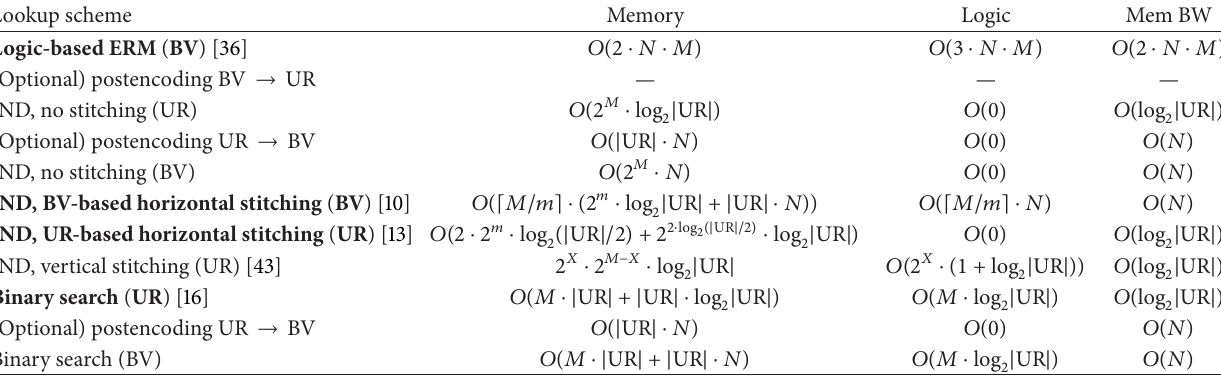
Table 3: Comparison of considered lookup